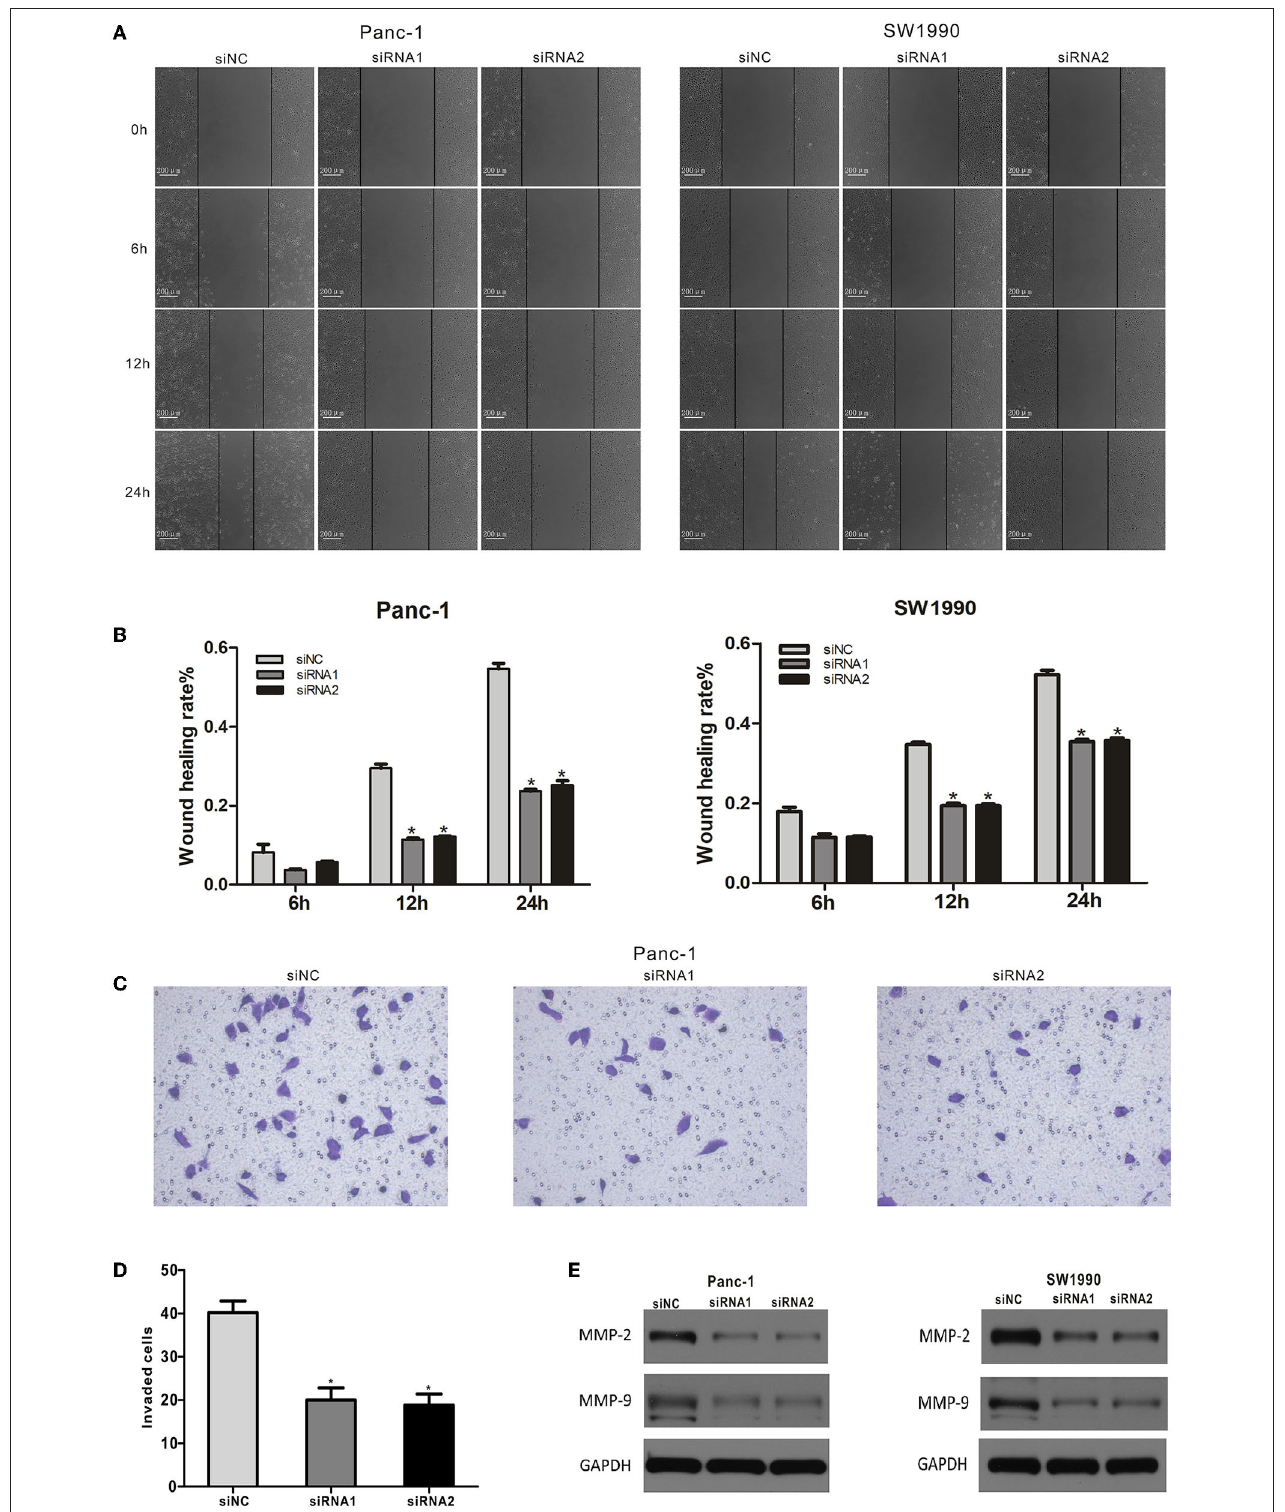
FIGURE 6 | CAPN2 expression regulates the migration and invasion of PC cells in vitro . (A,B) The migratory abilities of siRNA1,2-transfected Panc-1 cells and SW1990 cells were detected by a wound healing assay. Representative images and the quantitative analysis of the distance between wound edges at 6, 12, and 24 h. (C,D) Cell migratory abilities were detected by the Transwell migration assay. Quantitative analysis and representative images of the number of migrating cells in siRNA#2-transfected Panc-1 cells and control cells. (E) Western blot analysis shows that MMP9 and MMP2 protein levels were significantly reduced in CAPN2-silenced Panc-1 cells and SW1990 cells compared with that in control cells. * P < 0.05.